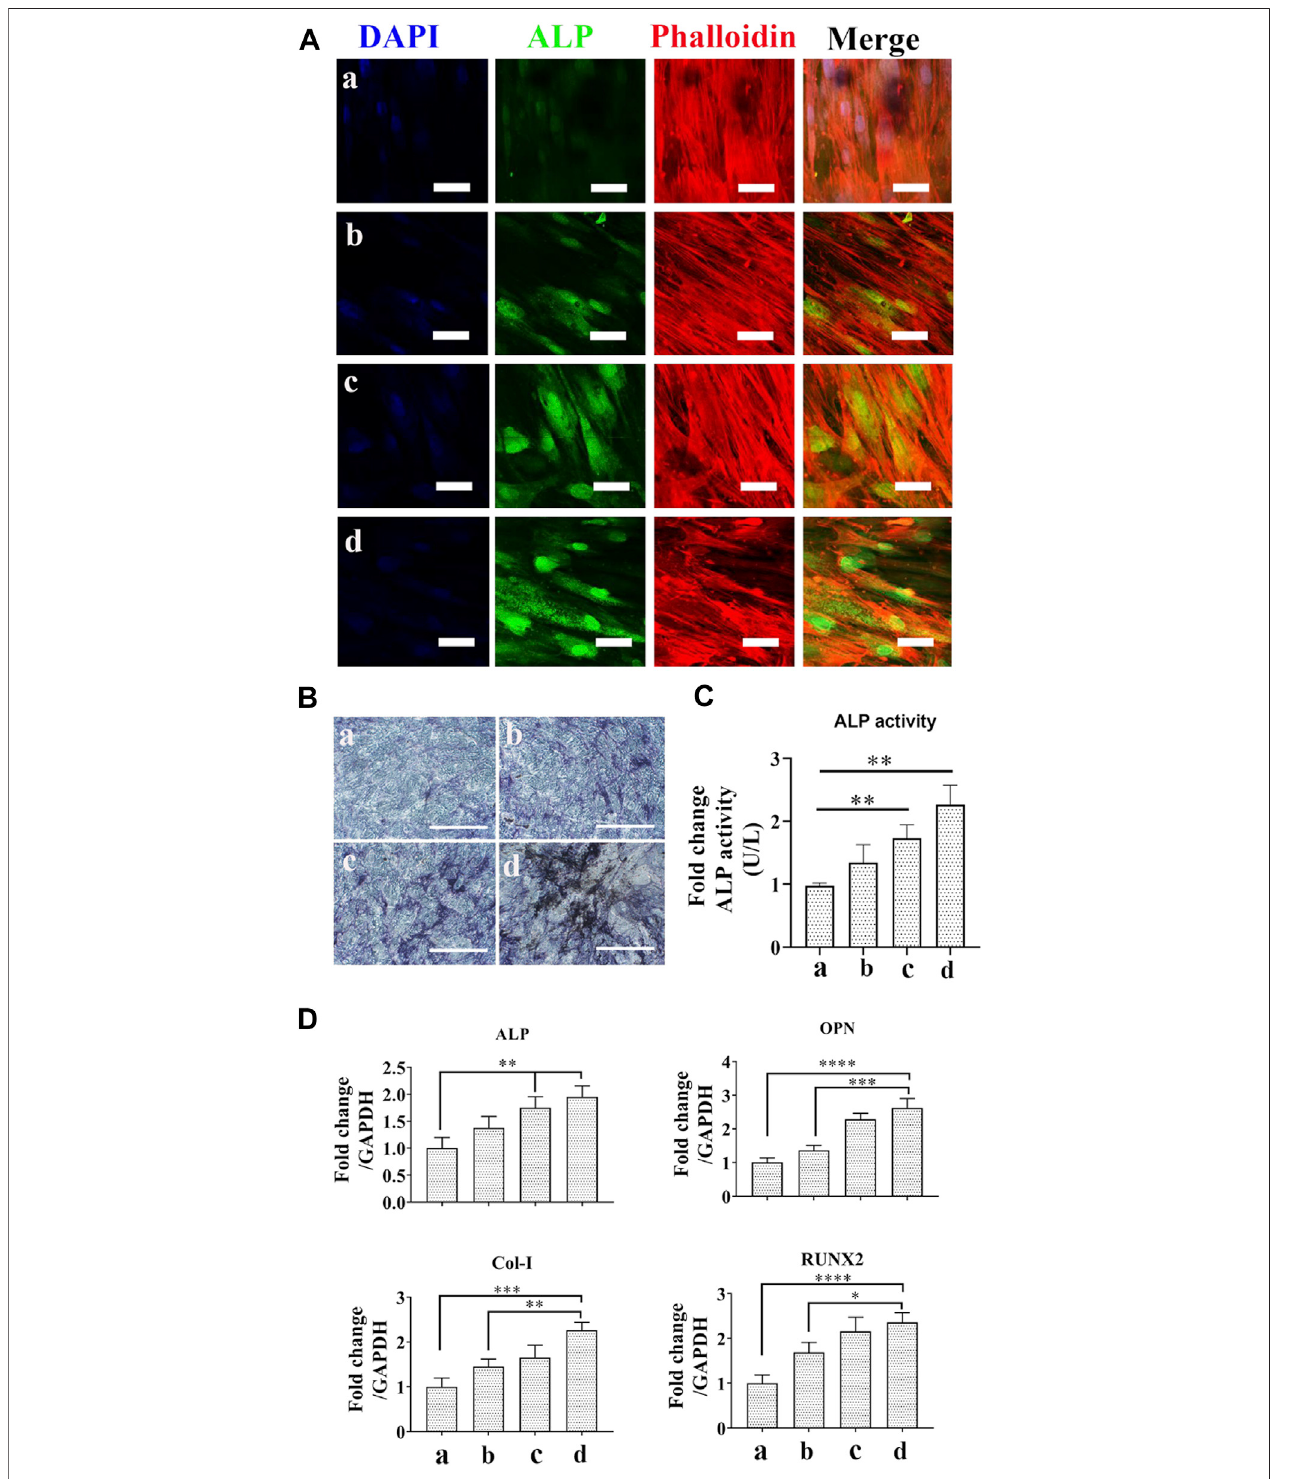
FIGURE 6 | Effect of the exosome and Ag hybrid scaffold on hBMSC differentiation. (A) Representative CLSM images of ALP expression. a (cid:2) PCL/PDA, b (cid:2) PCL/ PDA+Ag, c (cid:2) PCL/PDA+exosome, and d (cid:2) PCL/PDA+Ag+exosome. The cytoskeleton was stained with phalloidin (red), and nuclei were stained with DAPI (blue). RepresentativeCLSMimagesareshowninthe fi gure( n (cid:2) 3).Scalebars (cid:2) 50 μ m. (B) RepresentativeimagesofALPstaining.ALPactivitywasexaminedbyALPstaining. Scale bars (cid:2) 200 μ m. (C) ALP activity. ALP activity was measured using Alkaline Phosphatase Assay Kit. Error bars denote the mean ± SD ( n (cid:2) 3). ** indicates signi fi cant difference ( p < 0.01). (D) Relative expression of osteogenesis-related genes. Error bars denote the mean ± SD ( n (cid:2) 3). Signi fi cant differences (** p < 0.01, *** p < 0.005, and **** p < 0.001).